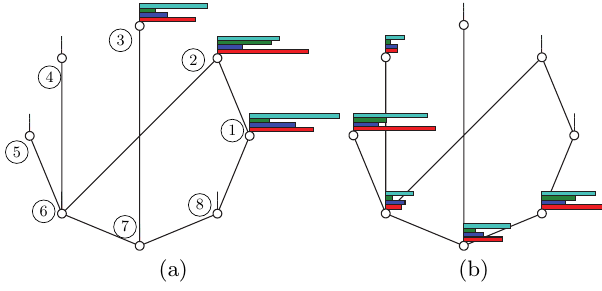
Figure 1: A strongly connected instance of a graph with 8 tasks (nodes), and possibilities of switching between tasks (edges). The system includes 4 traits. The trait abundance is represented by a bar plot. (a) Initial distribution (b) Desired